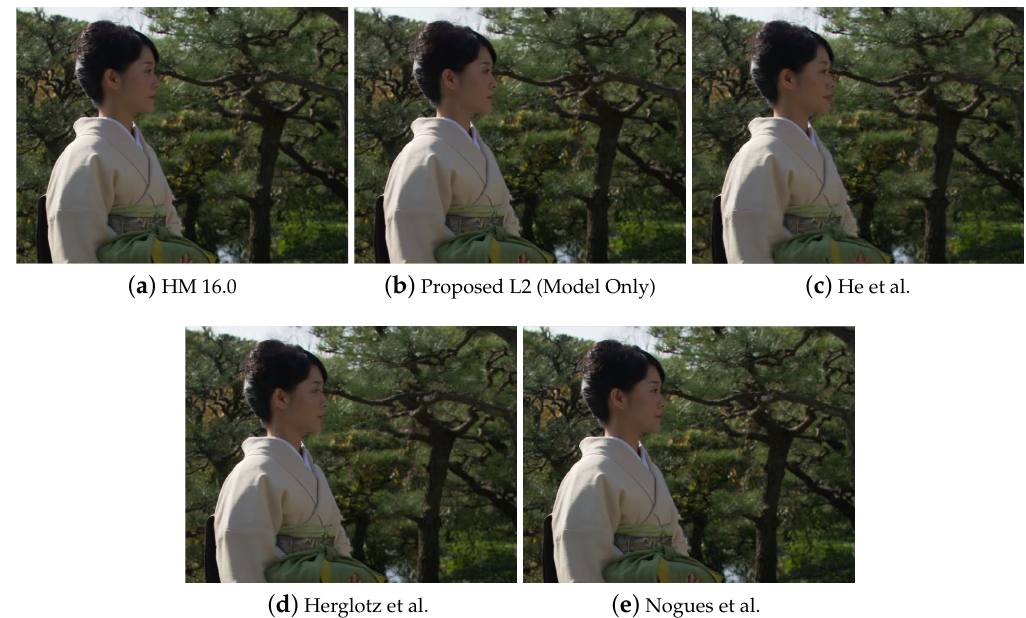
Figure 5. An illustration on the visual quality impact of the reconstructed video sequences of bit streams prepared by the ( a ) HM 16.0 encoder, ( b ) proposed algorithm, and other state-of-the-art algorithms proposed by ( c ) He et al. [20], ( d ) Herglotz et al. [46], and ( e ) Nogues et al. [34]. The figures correspond to the frame number 36 of the “Kimono HD” sequence encoded at 2